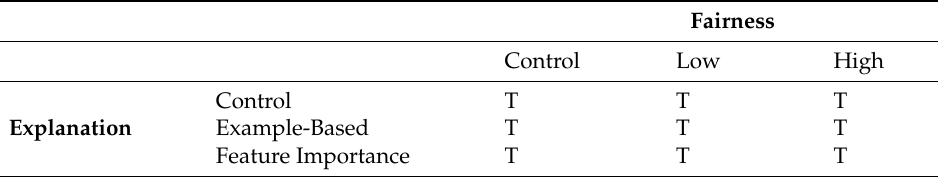
Table 1. Experiment task